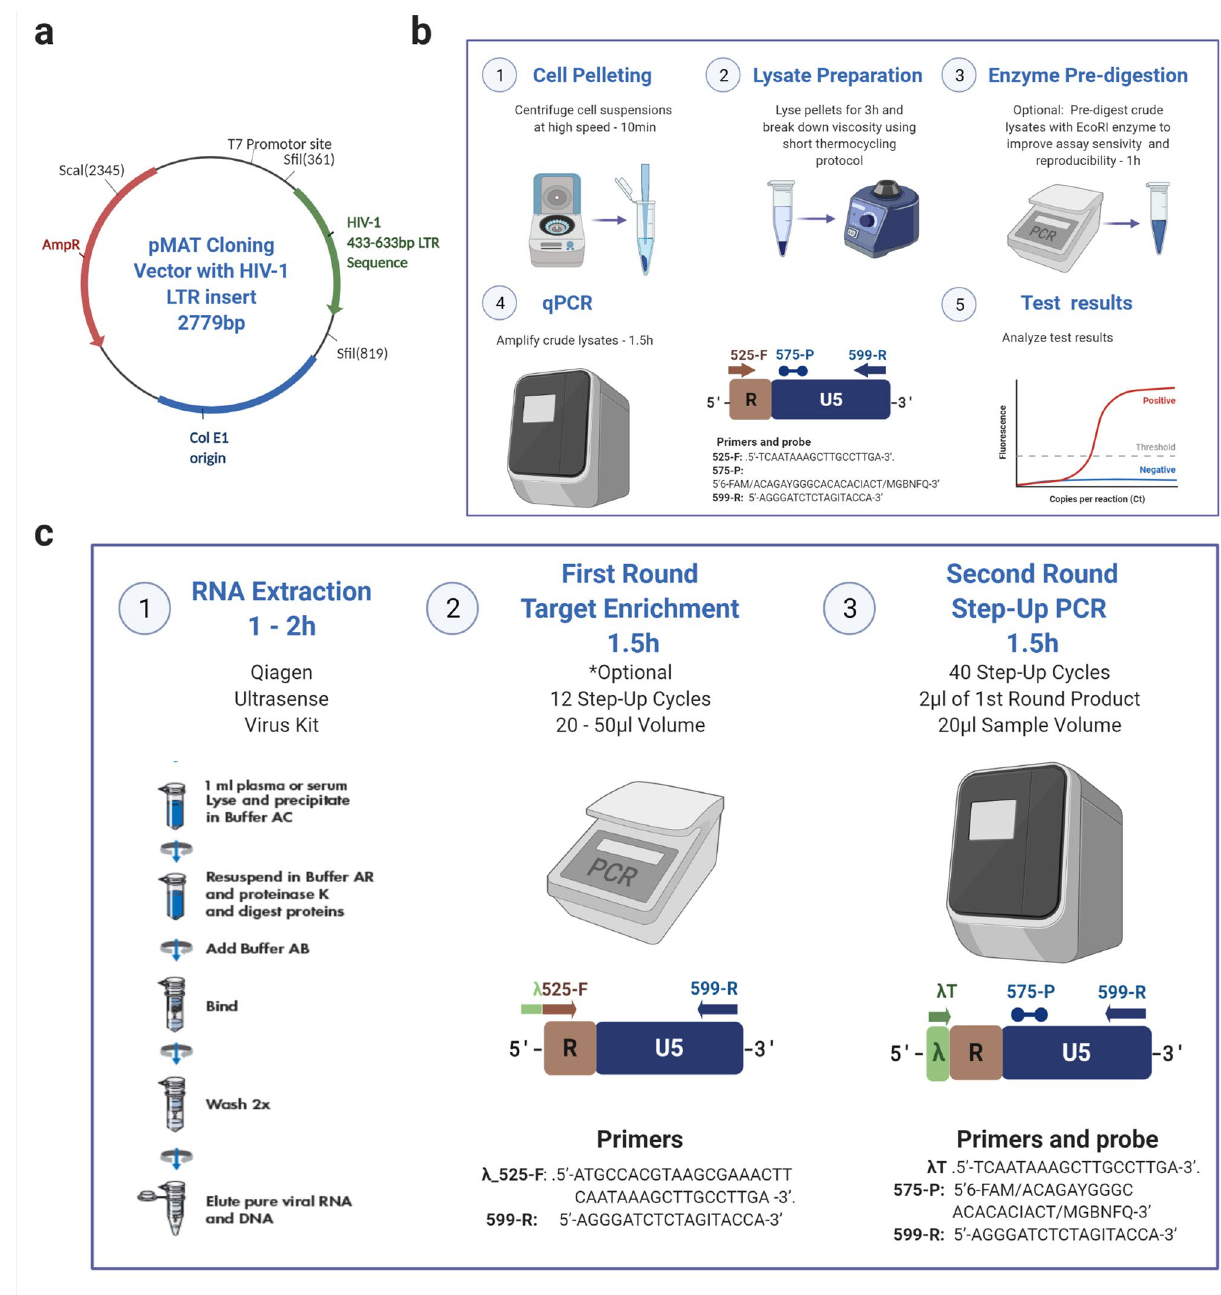
Figure 1. Revised qPCR and RTqPCR quantification assay synthetic standard and formats. Created with BioRender.com. ( a ) Synthetic DNA plasmid template containing the 433–633 HIV-1 LTR insert was linearized by Sca I and used for standard curve generation in the HIV-1 LDAs. RNA transcripts from the linearized DNA plasmid were made using the T7 promoter site and were used as HIV-1 RNA controls. ( b ) Protocol for Non-nested qPCR on crude DNA lysates. ( c ) Protocol for semi-nested RT-qPCR on RNA